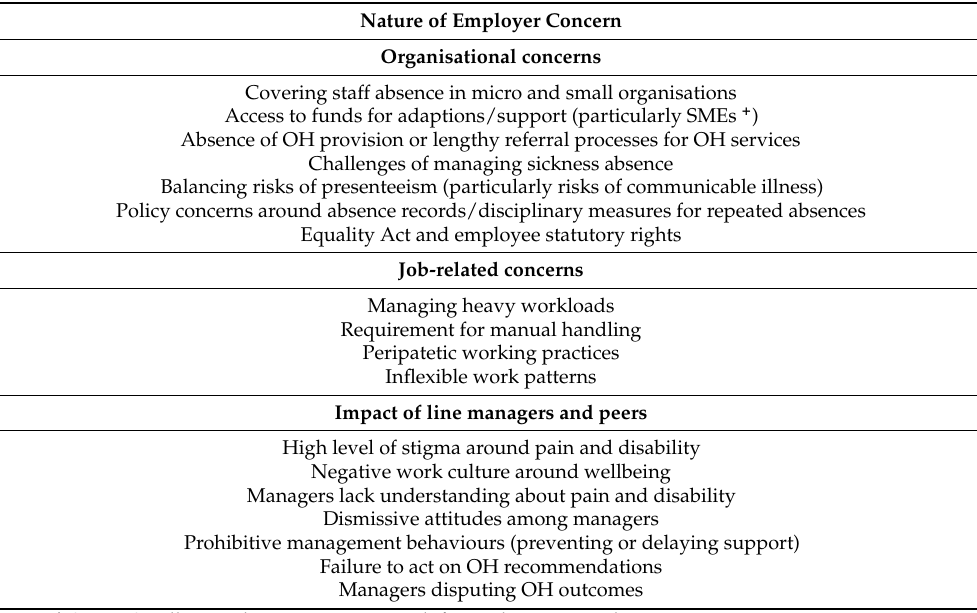
Table 4. Employer concerns and